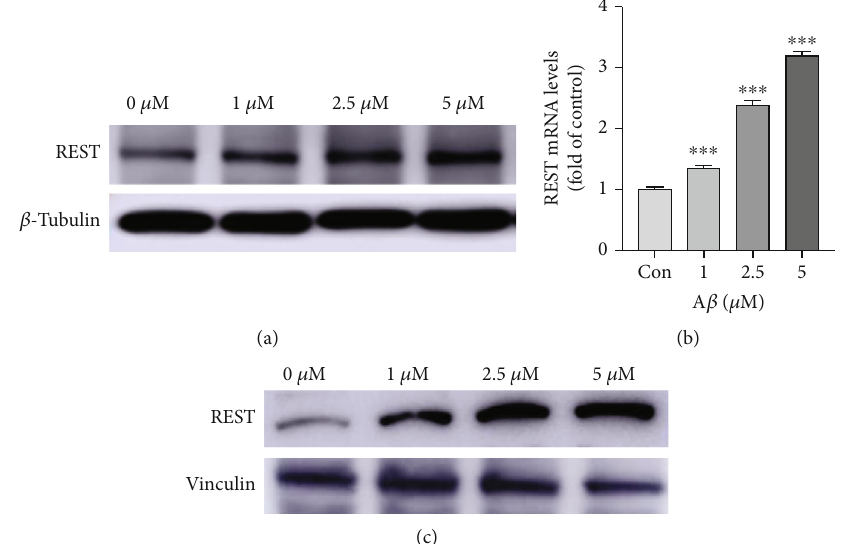
Figure 2: A β induced REST expression and nuclear translocalization. (a, b) Under the treatment of A β the mRNA level were upregulated. (c) With the increase of concentration of A β ∗∗∗ P < 0 : 001 vs.